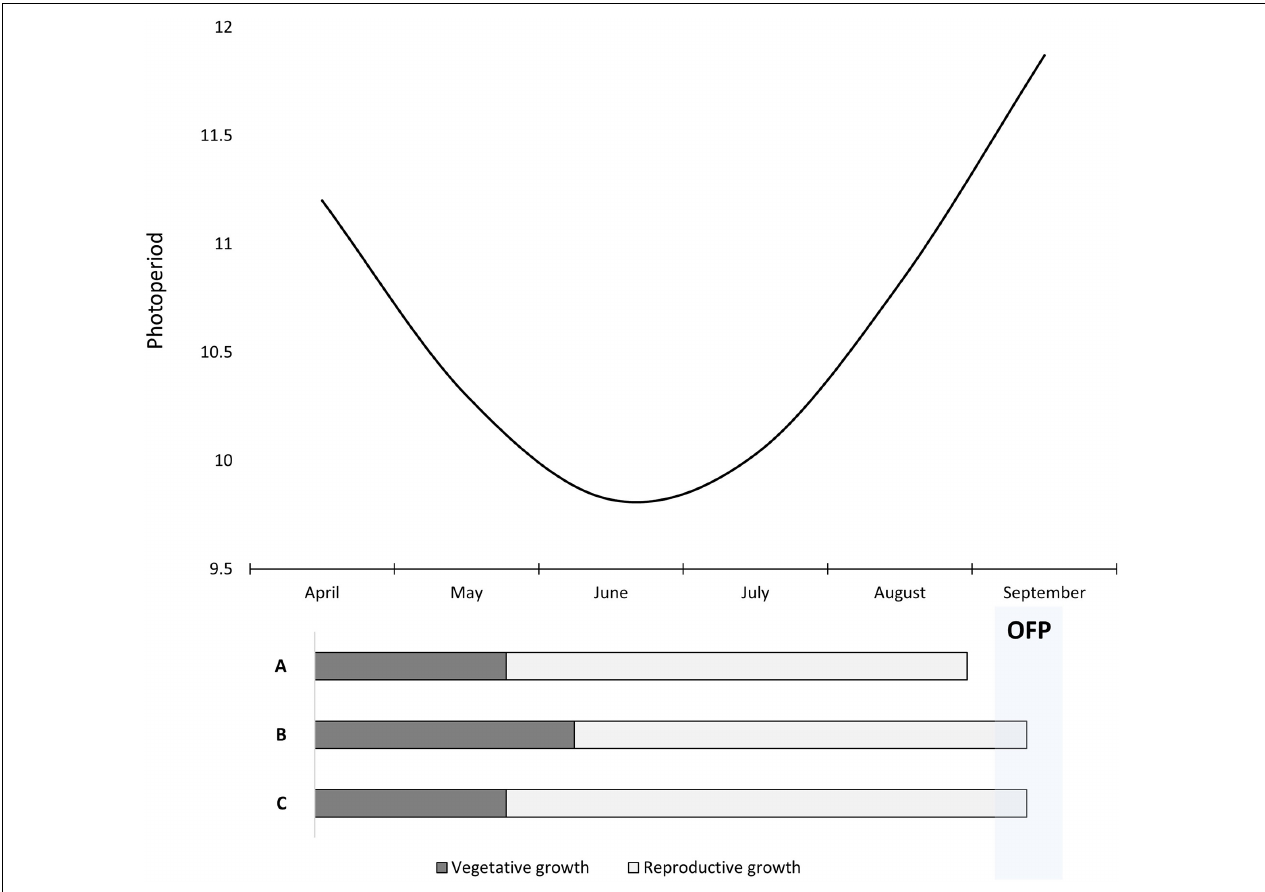
FIGURE 6 | A schematic depicting day length for Adelaide, South Australia from April to September. Shown below is a representation of Spartacus CL sown too early in April with three different management scenarios. Scenario A is the control which experiences 11-h days in April, accelerating the transition to reproductive growth and causing flowering to occur before the OFP. Scenario B demonstrates early sowing but with an application of trinexapac-ethyl at GS13 which extends the vegetative growth phase and resulting in flowering occurring within the OFP. Scenario C has a late trinexapac-ethyl application at GS31 which extends the reproductive growth phase but results in flowering being delayed into the OFP as